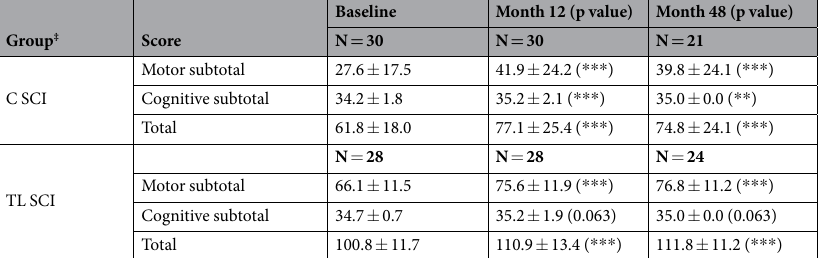
Table 4. Functional independence measure in each group † . † Compared with baseline, based on Wilcoxon signed rank test. Values are presented as means ± SDs. ‡ C SCI = cervical spinal cord injury; TL SCI = thoracolumbar spinal cord injury. * Significant at p < 0.05. ** Significant at p < 0.005. *** Significant at p < 0.0001.